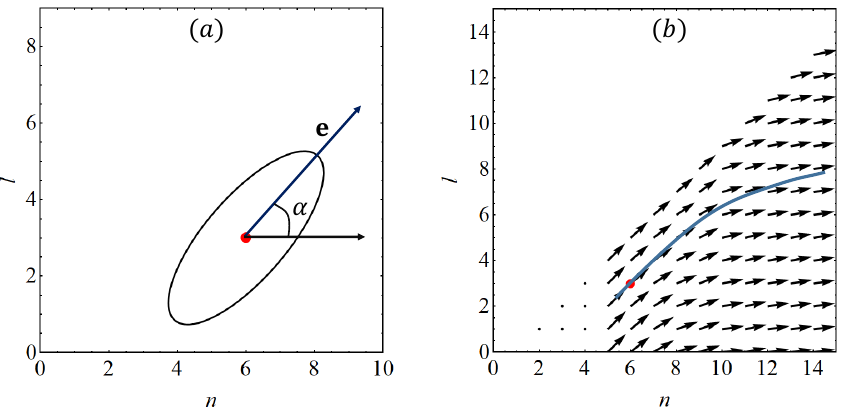
Figure 2. (Color online) ( a ) Local diffusion ellipse. The main diffusion direction e corresponds to the main axis of this ellipse and forms an angle α to the n axis. ( b ) The vector field e . The blue line corresponds to the streamline of this field. The initial state n 0 , l 0 is shown by the red